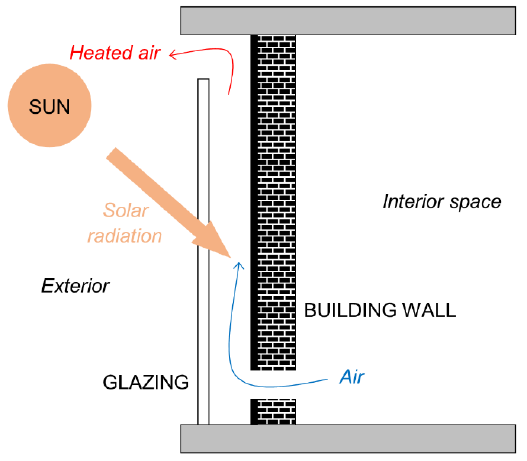
Figure 2. Schematic of a solar chimney integrated on the vertical wall.